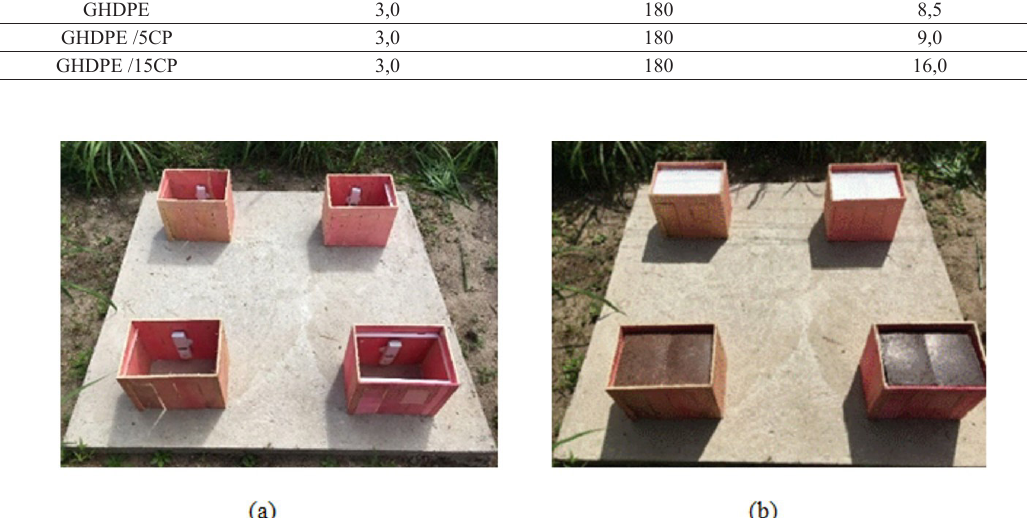
Figure 3. Prototype assembly: (a) fitting of thermo-hygrometer sensors; and (b) placement of the ceiling.